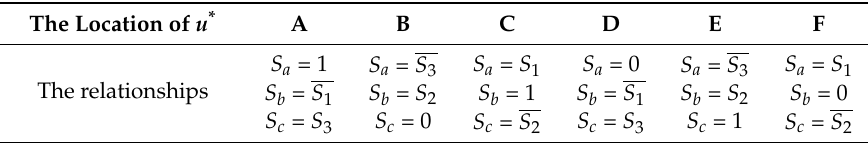
Figure 11. The overall smoothly transitive fixed frequency hysteresis current control (ST-FHCC)